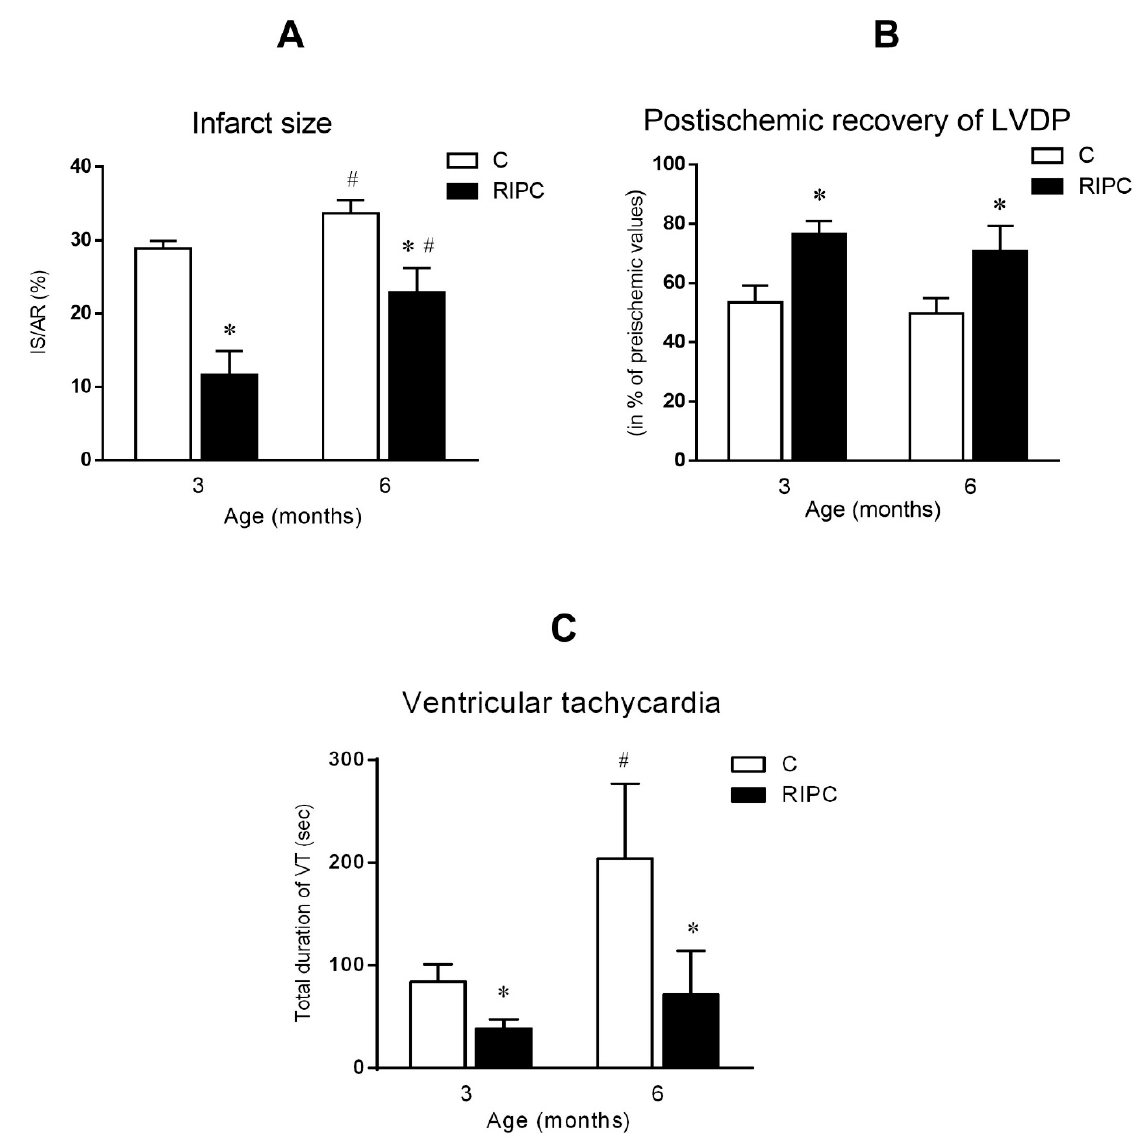
Figure 1. The effect of maturation on the ischemia/reperfusion injury in the non-adapted control and adapted (remote preconditioned) rat hearts. ( A )—size of infarction. ( B )—post-ischemic recovery of function. ( C )—occurrence of reperfusion-induced ventricular arrhythmias. RIPC—remote ischemic preconditioning, IS—infarcted area of left ventricle, expressed in % of risk area (AR), LVDP—left ventricular developed pressure (LV systolic minus LV diastolic pressure). VT—ventricular tachycardia. Values are means ± S.E.M. from 8–12 hearts per group. * p < 0.05, RIPC vs. controls; # p < 0.05–0.01, vs. 3 months.